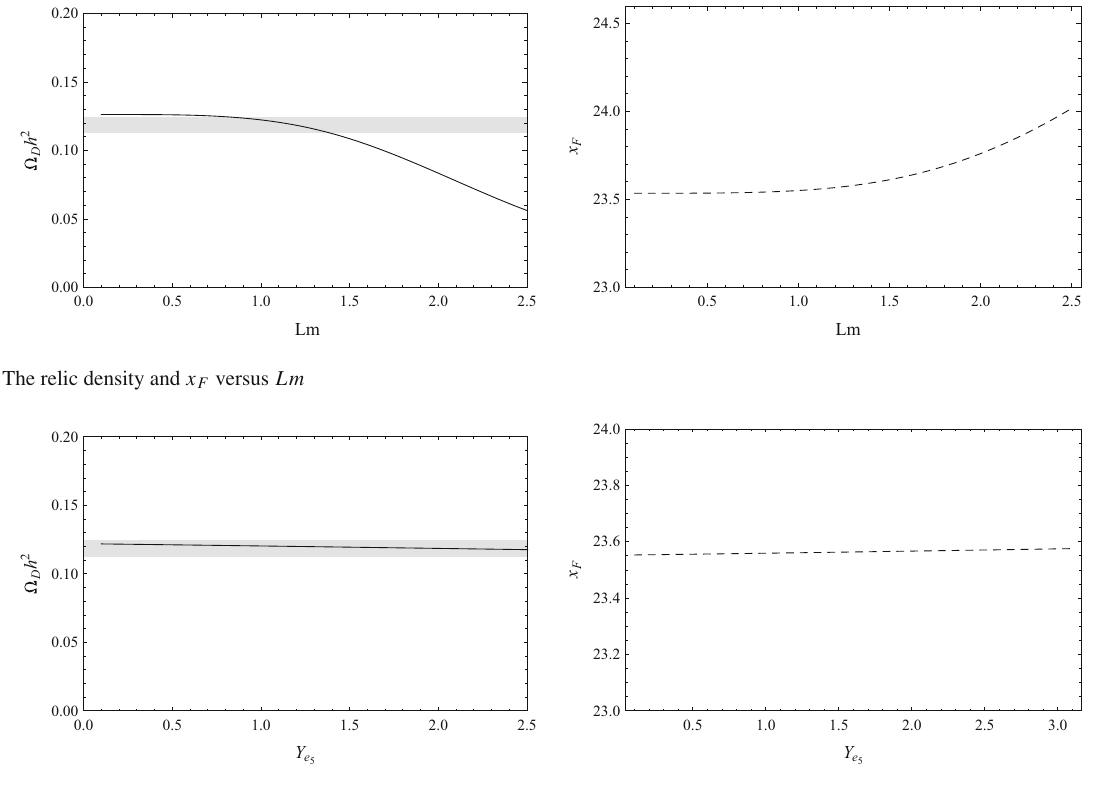
Fig. 6 The relic density and x F versus Y e